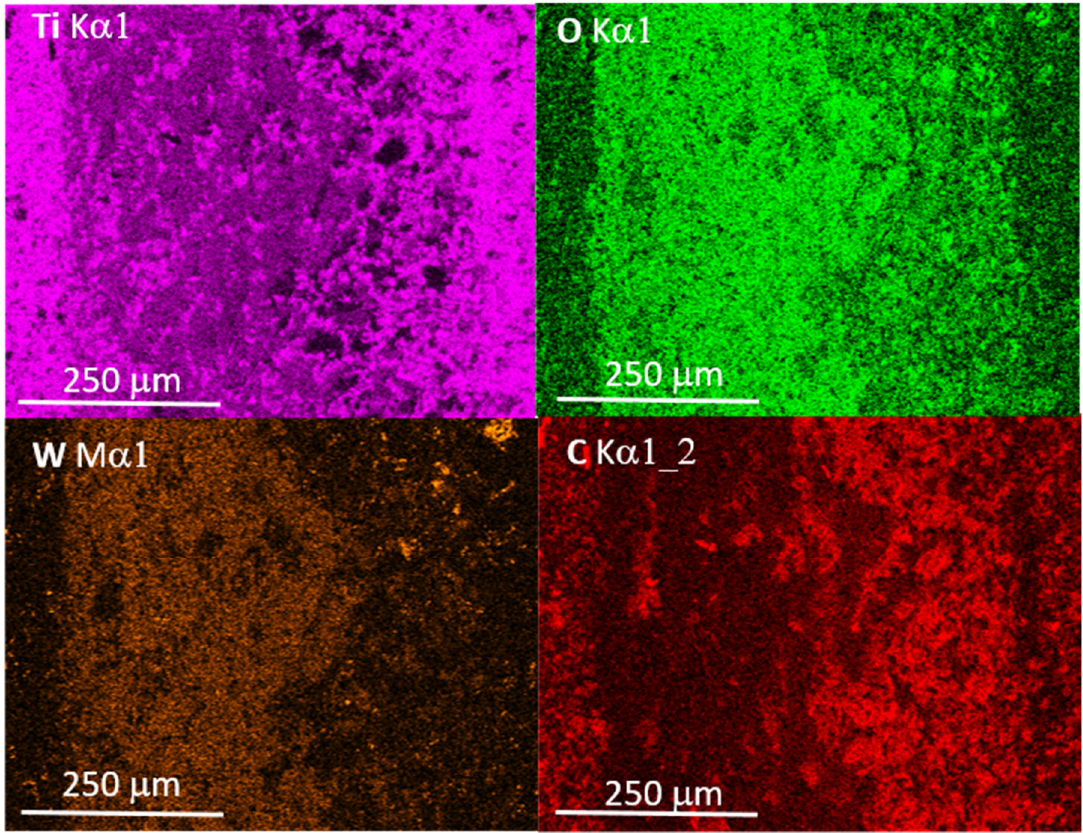
Figure 10. EDS elemental maps of Ti, O, W and C registered from the area presented in Figure 9b.